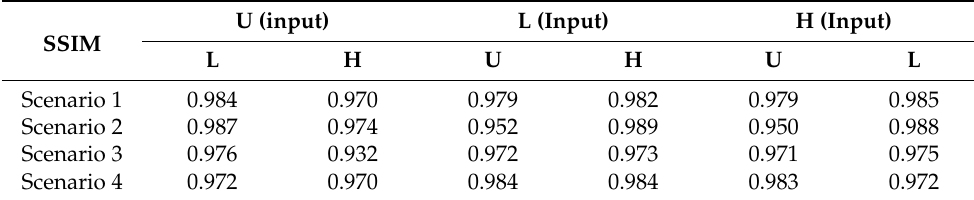
Table 1. Structure similarity indexes of fringe images generation with different frequencies. U rep- resents the unit-frequency fringe; L represents the low-frequency fringe; H represents the high- frequency